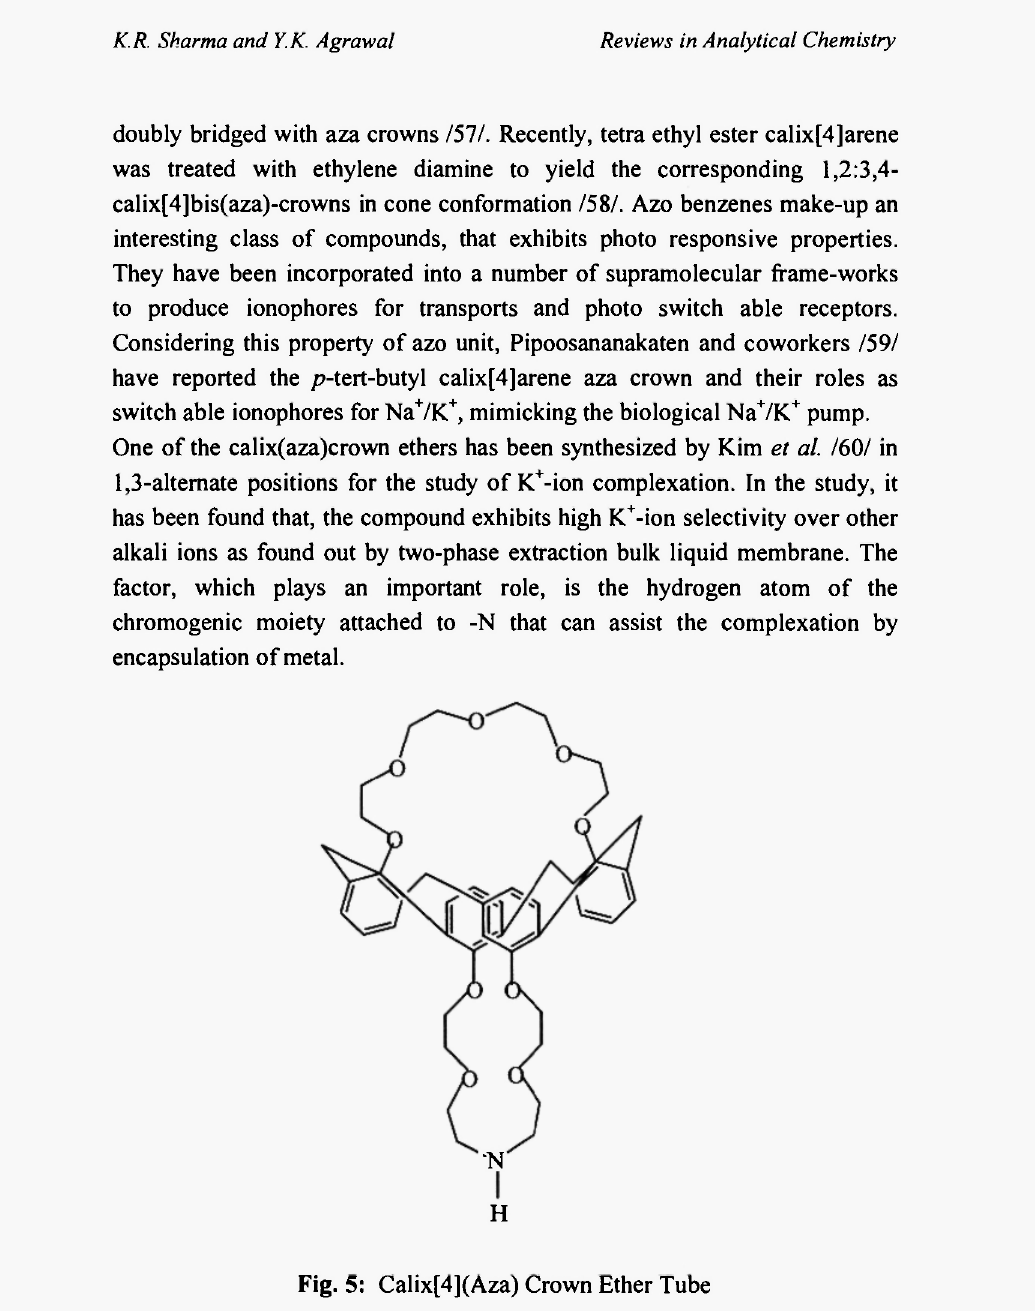
Fig. 5: Calix[4](Aza) Crown Ether